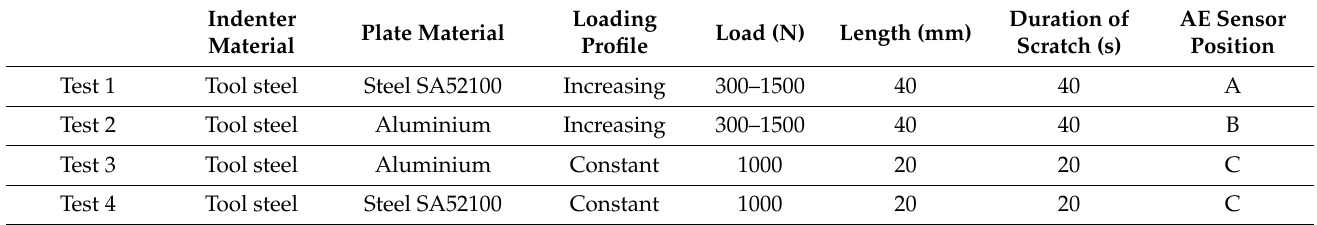
Figure 2. Bruker TriboLab test set up. Table 1. Test